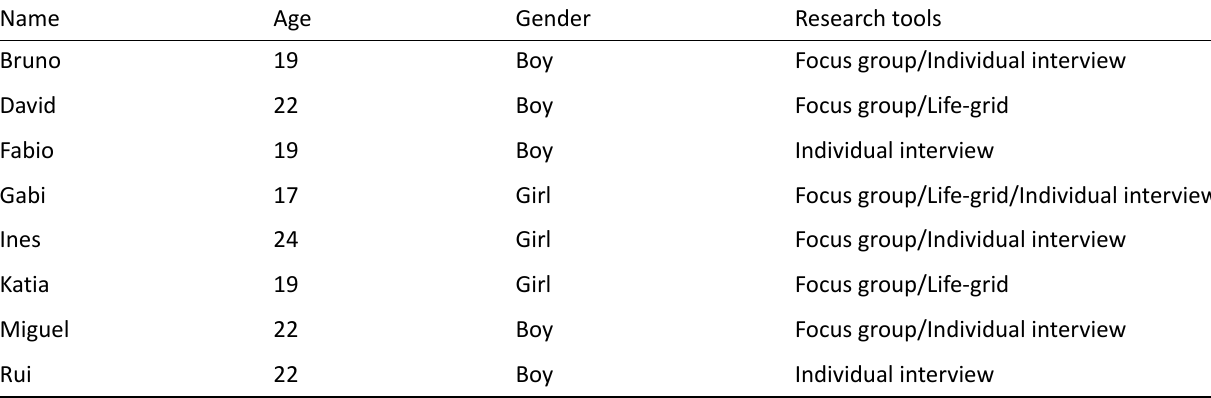
Table 2. Overview of participants’ gender, age, and involvement in research